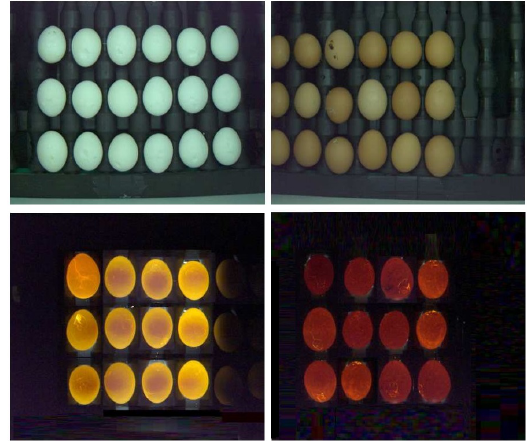
Figure 2. At the top of this image are two examples of images captured with upper lighting and at the bottom two images captured with bottom